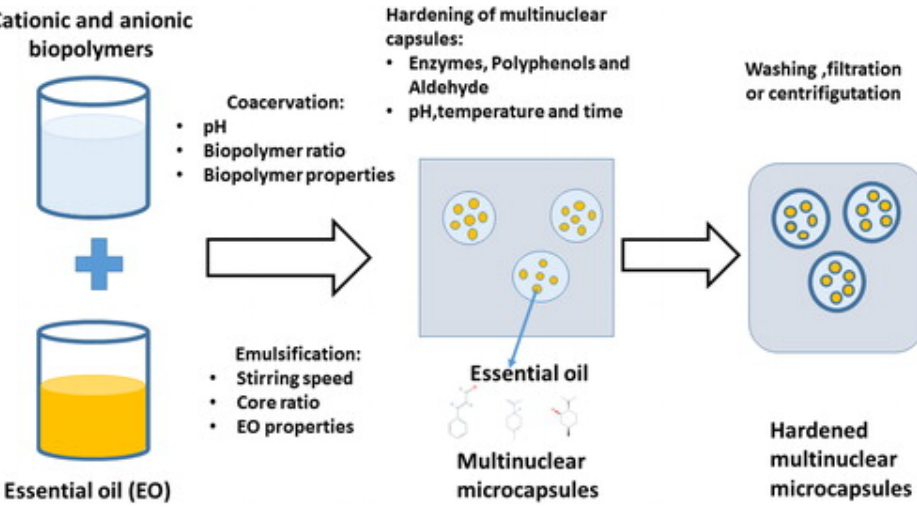
Figure 5. Microencapsulation of EOs via coacervation (reproduced with permission) [188].